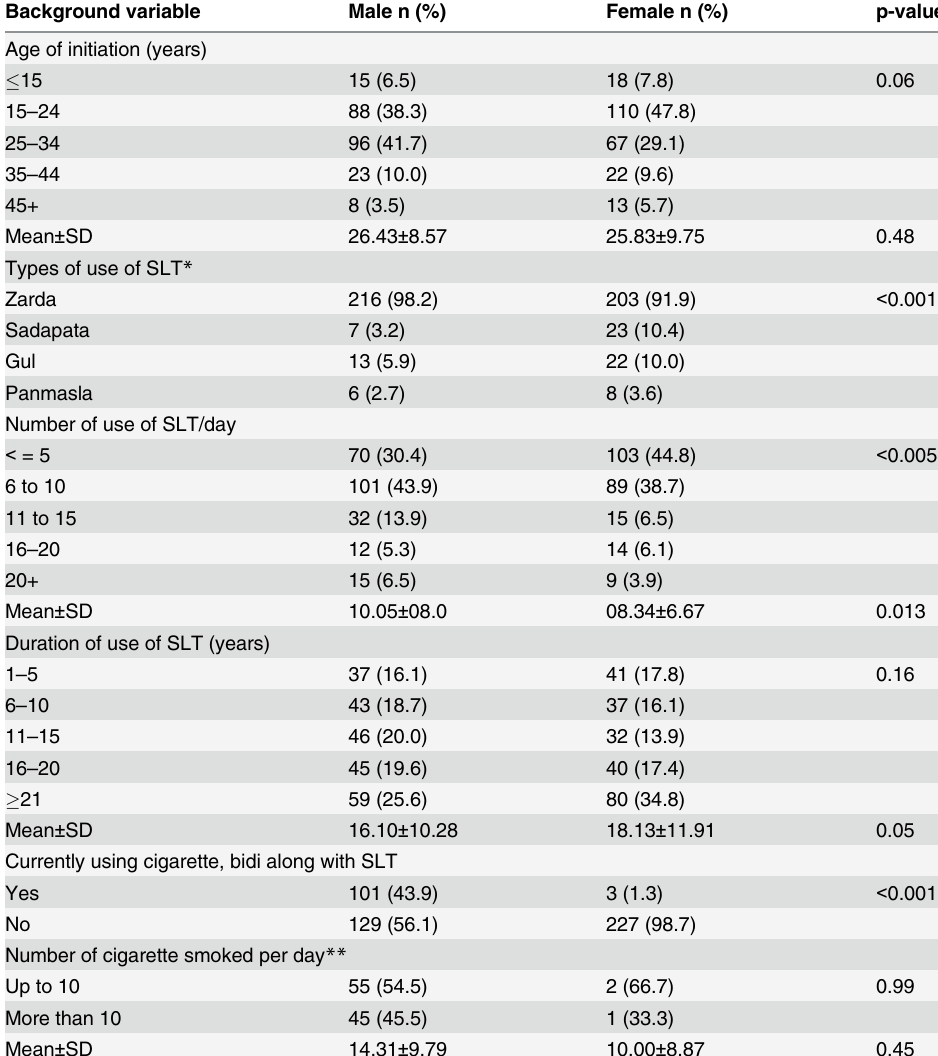
Table 2. Features of smokeless tobacco consumers by